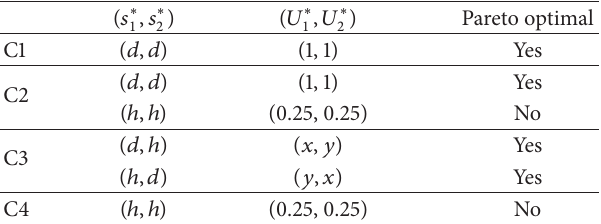
Table 2: Nash equilibria in the conflict game. Table 3: The conflict game: illustrative